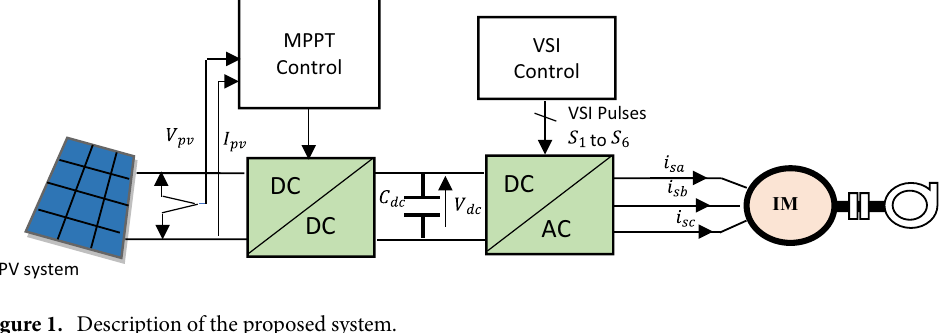
Figure 1. Description of the proposed